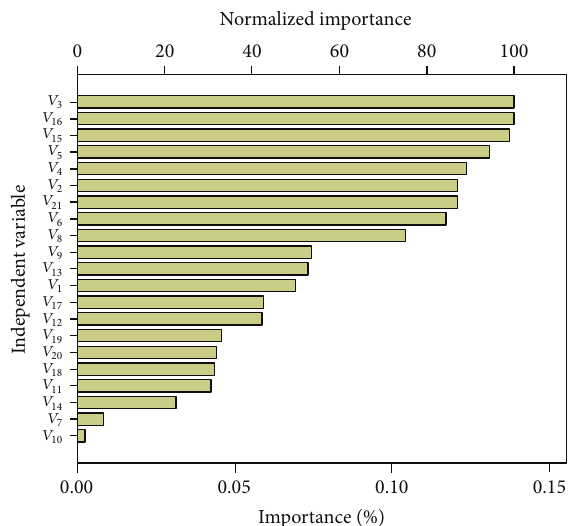
Figure 2: Normalized importance of factors using CRT method.